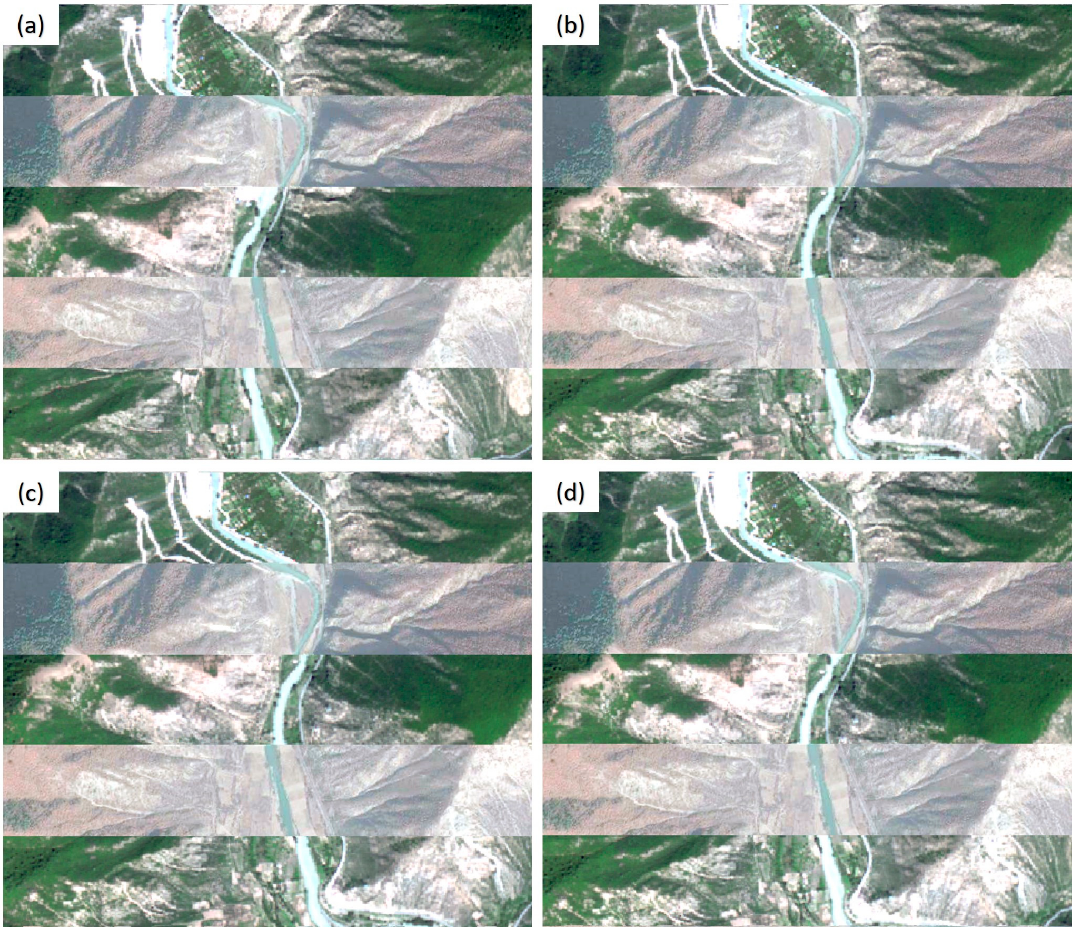
Figure 16. Registered images for the Jiuzhaigou dataset. ( a ) The original image; ( b ) the registered image of the proposed method; ( c ) the registered image of the Patch-SIFT method; and ( d ) the registered image of the SIFT method.